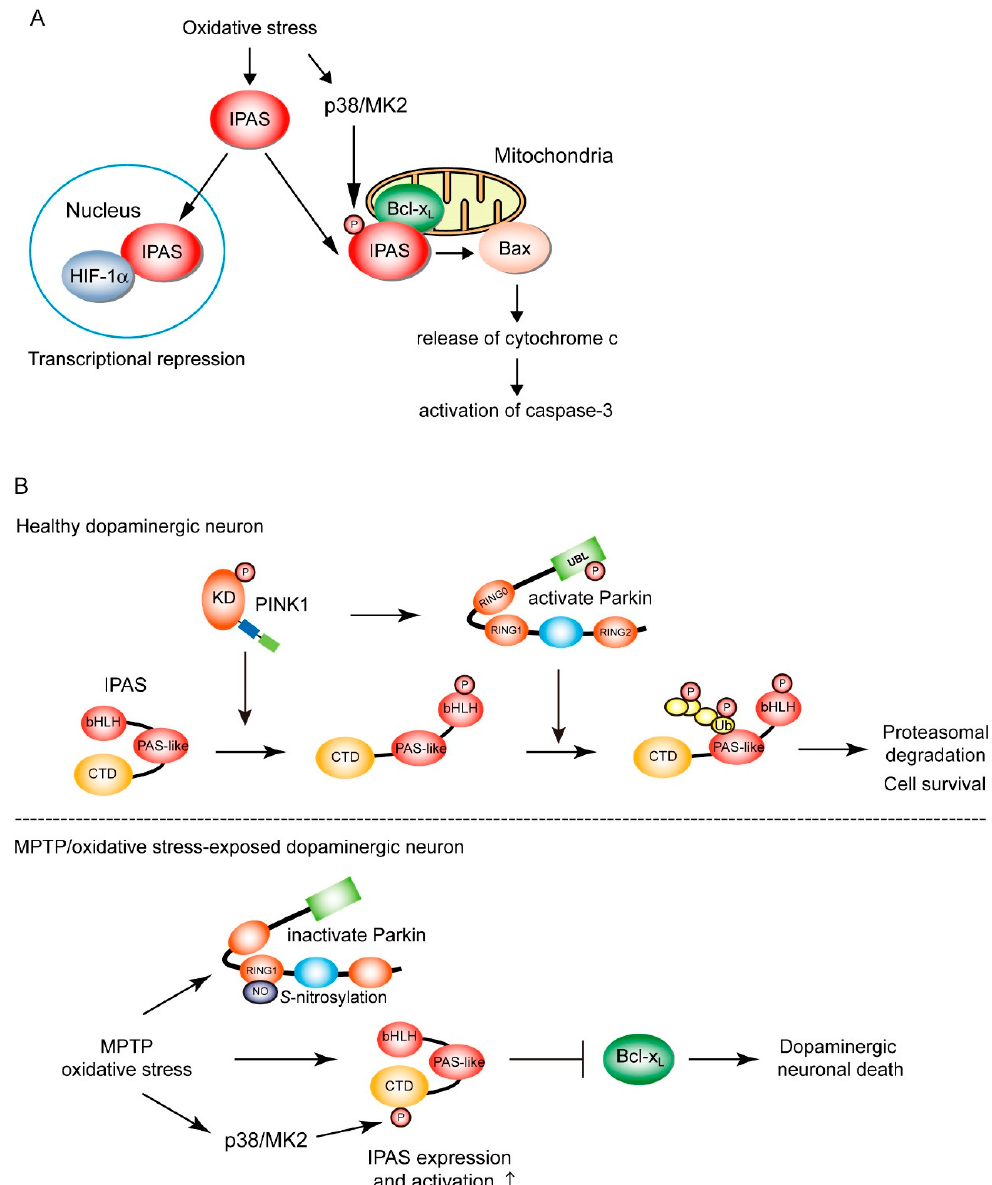
Figure 4. The PINK1-Parkin pathway regulates IPAS expression and inhibits neuronal death. ( A ) A model for the action of IPAS in transcriptional repression and apoptosis. Nuclear IPAS is bound to HIF-1 α and inhibits hypoxic responses by inhibiting HIF-1 α transcriptional activity. Mitochondrial IPAS is bound to Bcl-x L , Mcl-1, and A1a on the mitochondria and blocks the interaction of these proteins with Bax; thus activating of Bax, followed by release of cytochrome c and activation of caspase-3. p38-activated MK2 phosphorylates IPAS at Ser 184 , activating the pro-apoptotic functions of IPAS. IPAS has dual functions involved in the transcription repression of HIF-1 α and cell death. ( B ) In healthy neurons, IPAS Thr 12 is phosphorylated by PINK1 and then ubiquitinated by Parkin at lys 167–169 in the PAS-like region, leading to the proteasomal degradation of IPAS. Phosphorylation of IPAS at Thr 12 may induce a conformation change of IPAS to make the PAS-like region accessible to Parkin (top). The dopaminergic neurotoxin, MPTP, and other oxidative stresses strongly induce IPAS expression in the SNpc. Parkin is inhibited by S -nitrosylation or its ligase-dead pathologic mutation in PD. p38-activated MK2 may phosphorylate IPAS at Ser 184 under these conditions. These events activate IPAS pro-apoptotic activity which leads to dopaminergic neuronal death in the SNpc (bottom). KD: kinase domain. Arrow tracks indicate signal transduction or IPAS translocation to nucleus / mitochondria. An up-arrow indicates high level of expression and